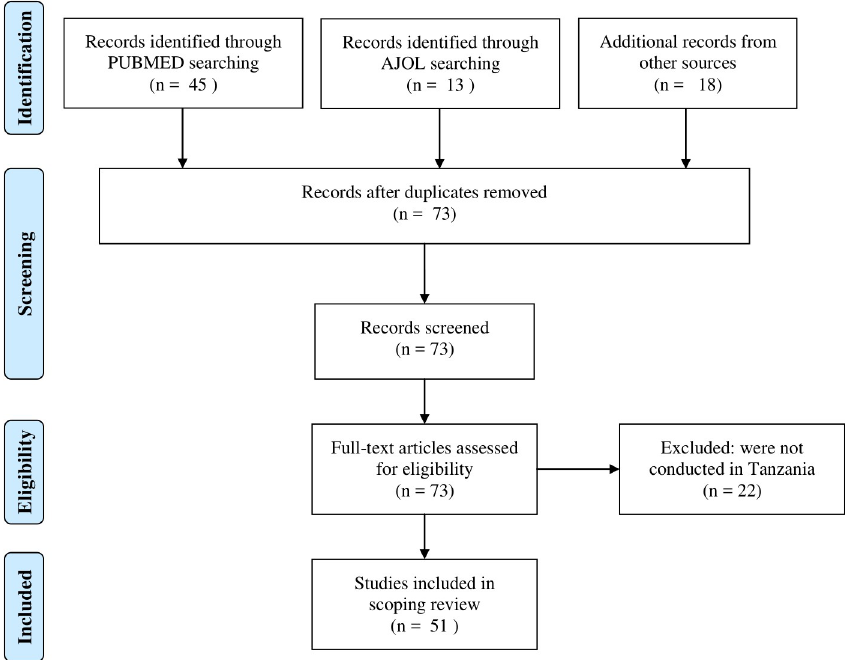
Fig 1. PRISMA diagram for a scoping review of Taenia solium taeniosis/cysticercosis research evidence in Tanzania, 1995–2018.